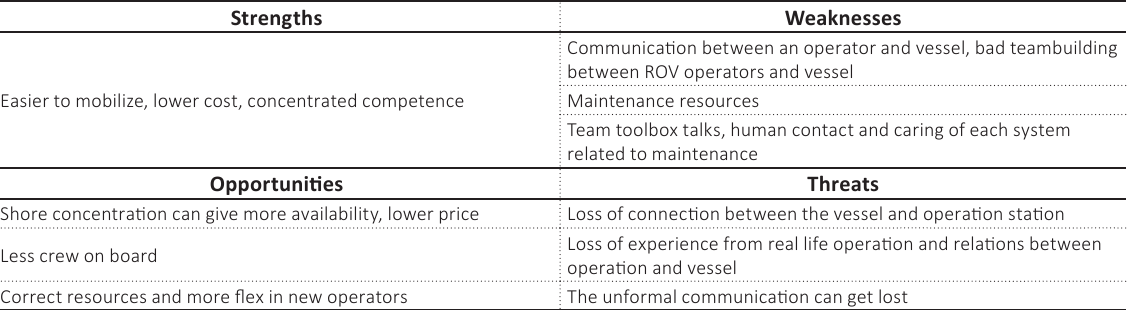
Table 4. SWOT analysis of the introduction of new ROVs systems (Contractors’ view)